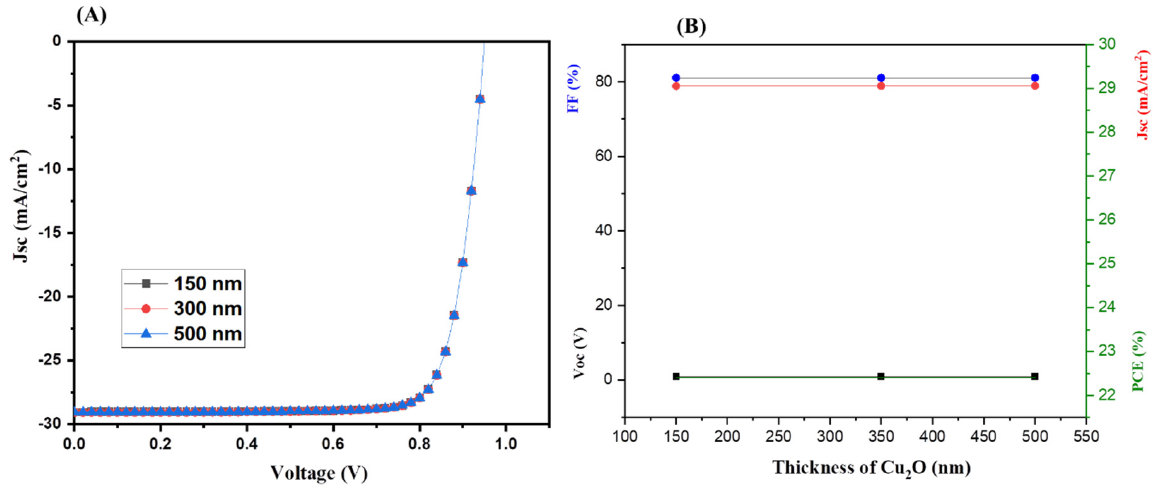
Figure 6. J–V curves ( A ) and photovoltaic parameters ( B ) of tandem PSCs using ZnSe as the ETL with different thicknesses of Cu 2 O.